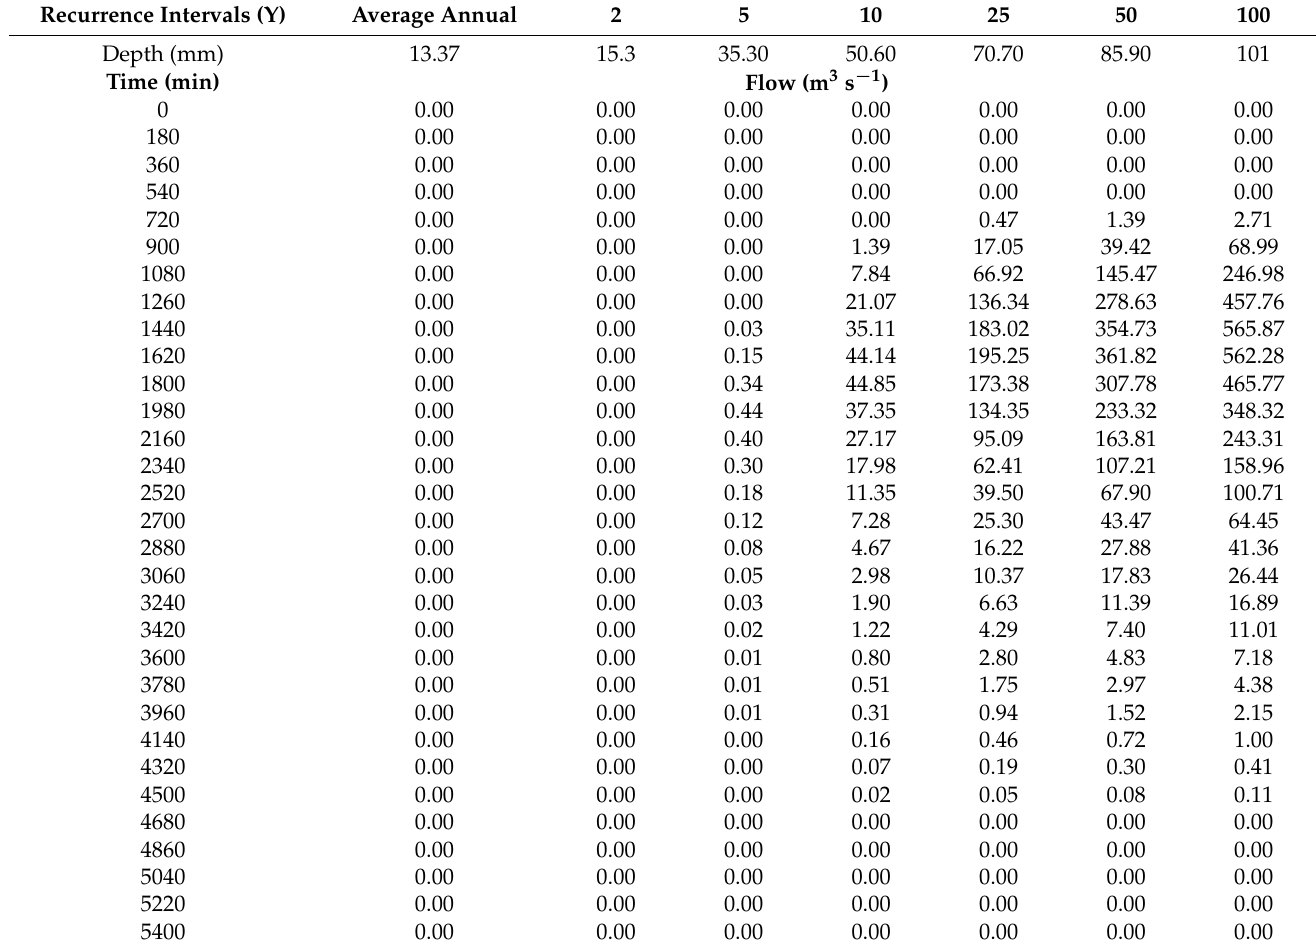
Table 2. Runoff discharge for W. El Aawag